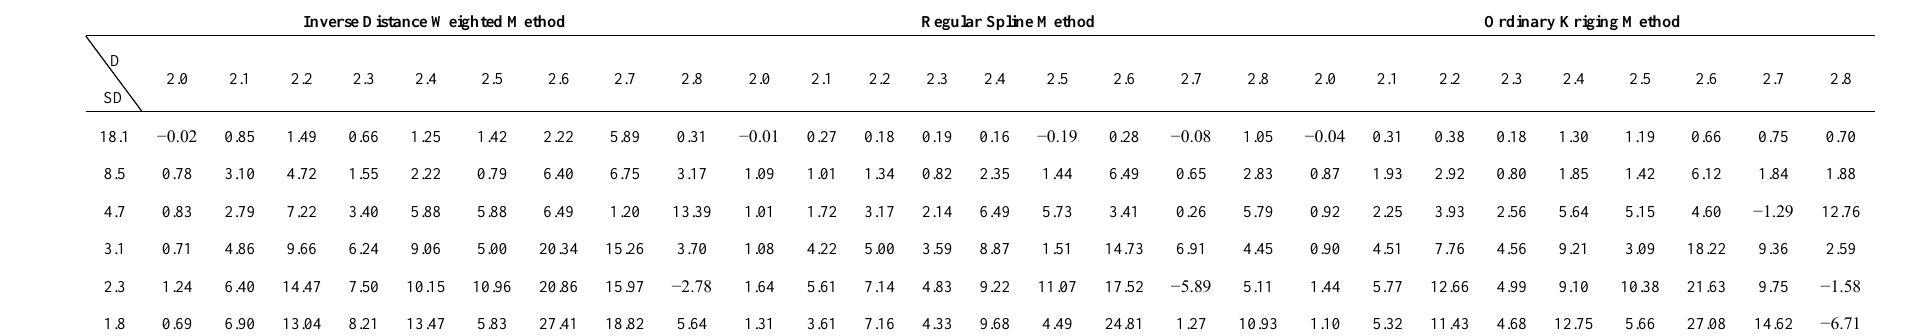
Table 5. The BIAS s under selective sampling mode (Unit: m).